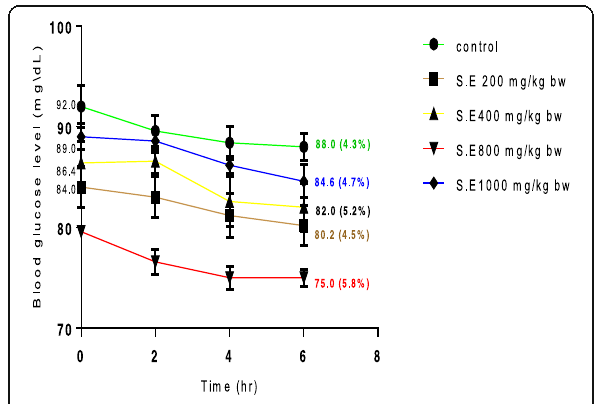
Fig. 1 Acute effect of SE on fasting blood glucose level (FGBL) in normoglycemic rats. Values are expressed as mean of six rats. Figures in parentheses are mean percentage reduction in fasting blood glucose level (FGBL)